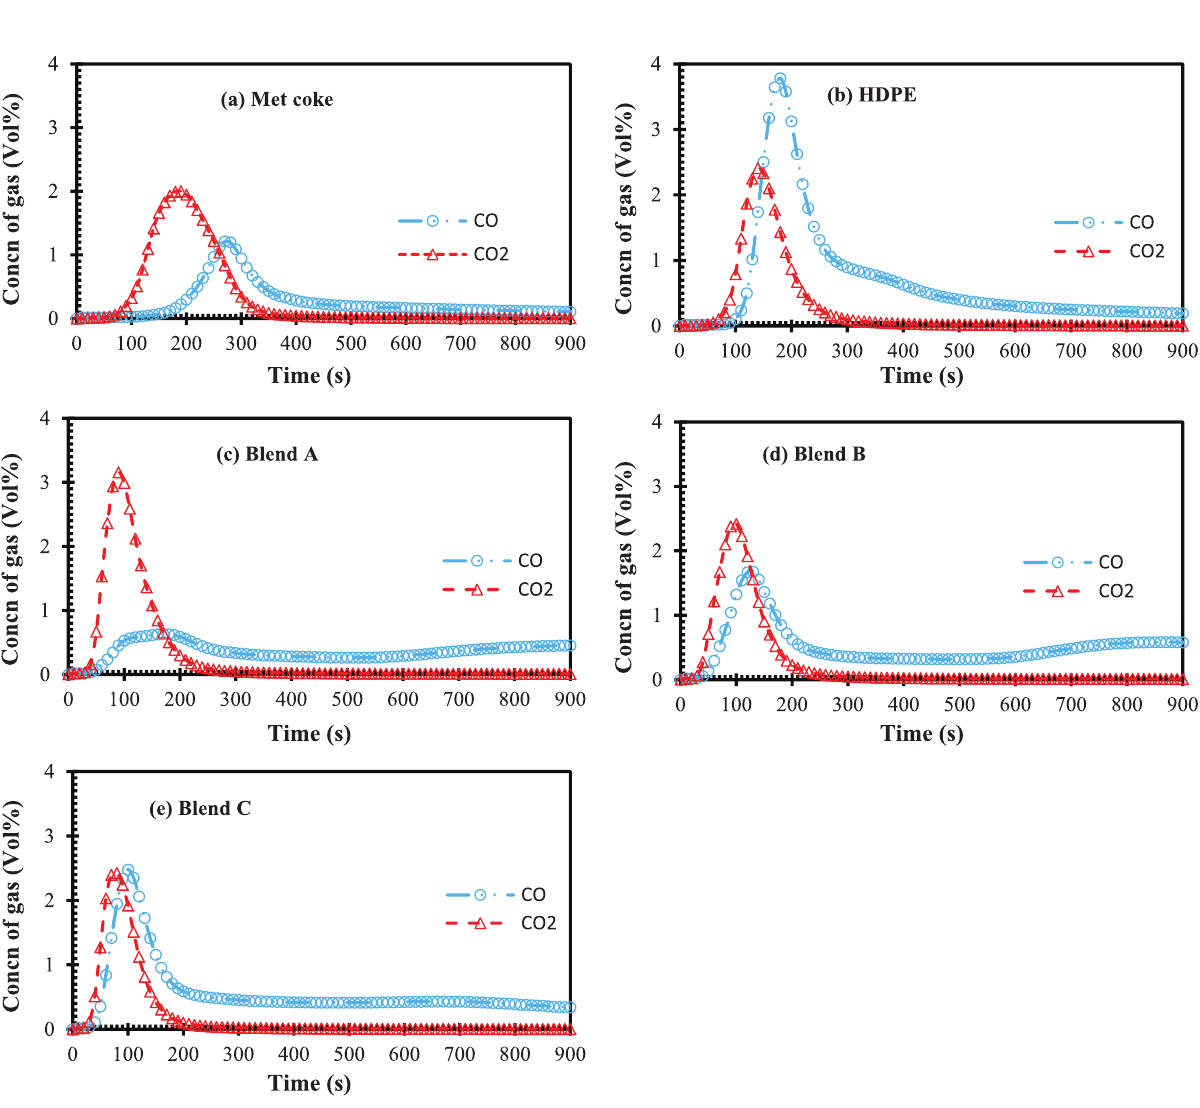
Fig. 8: Variation of gas composition (CO and CO 2 ) with time for compact reduced with each reductant at 1150 °C